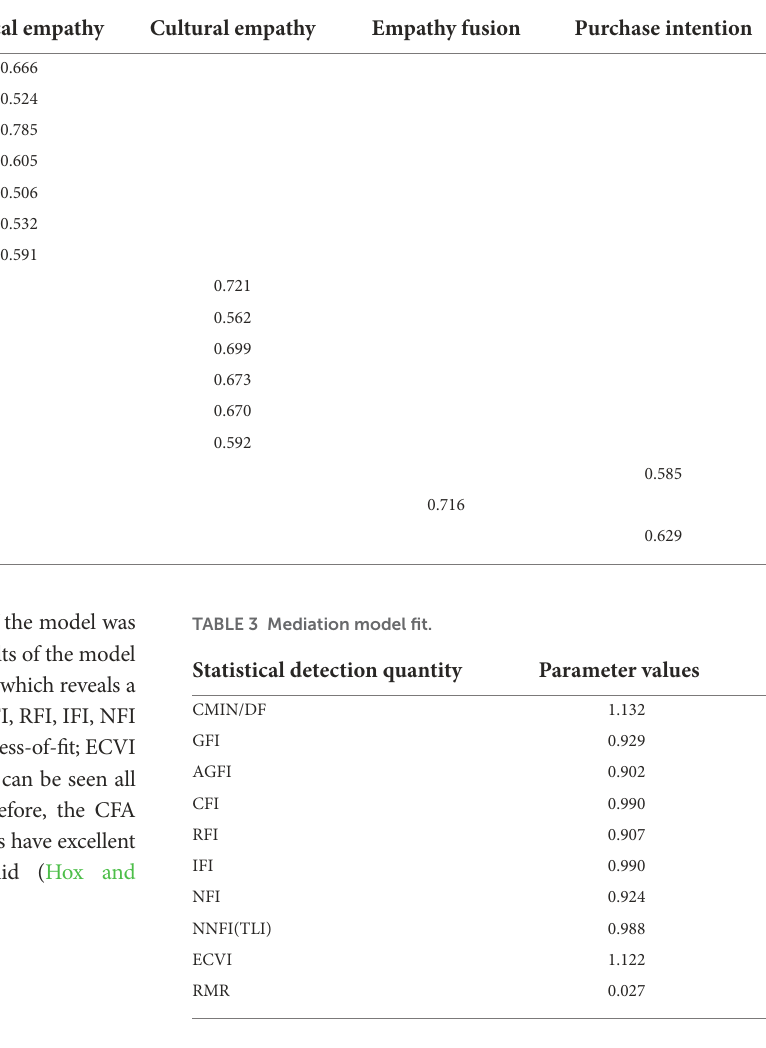
TABLE 2 The rotated component matrix